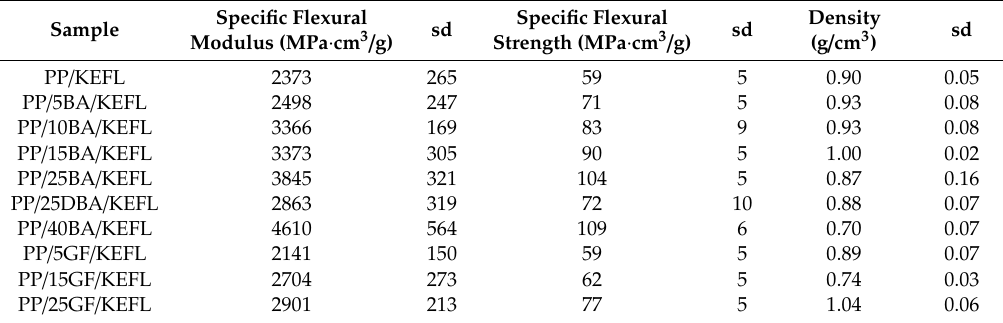
Table 3. Flexural analysis and density of the